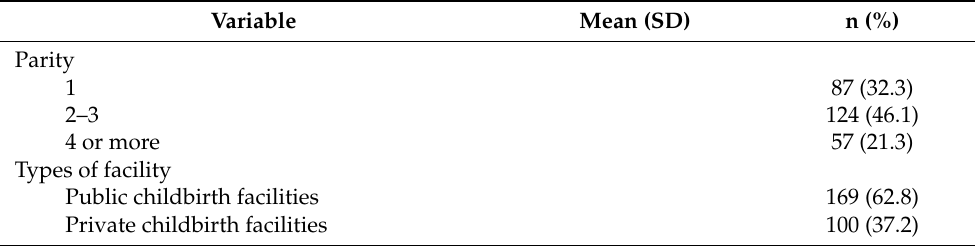
Table 3. Obstetric, childbirth experience and childbirth facilities characteristics (n =